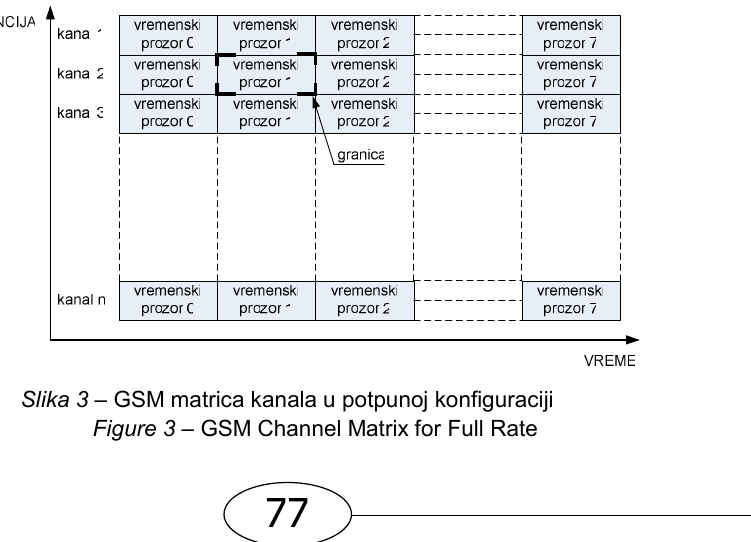
Figure 3 – GSM Channel Matrix for Full